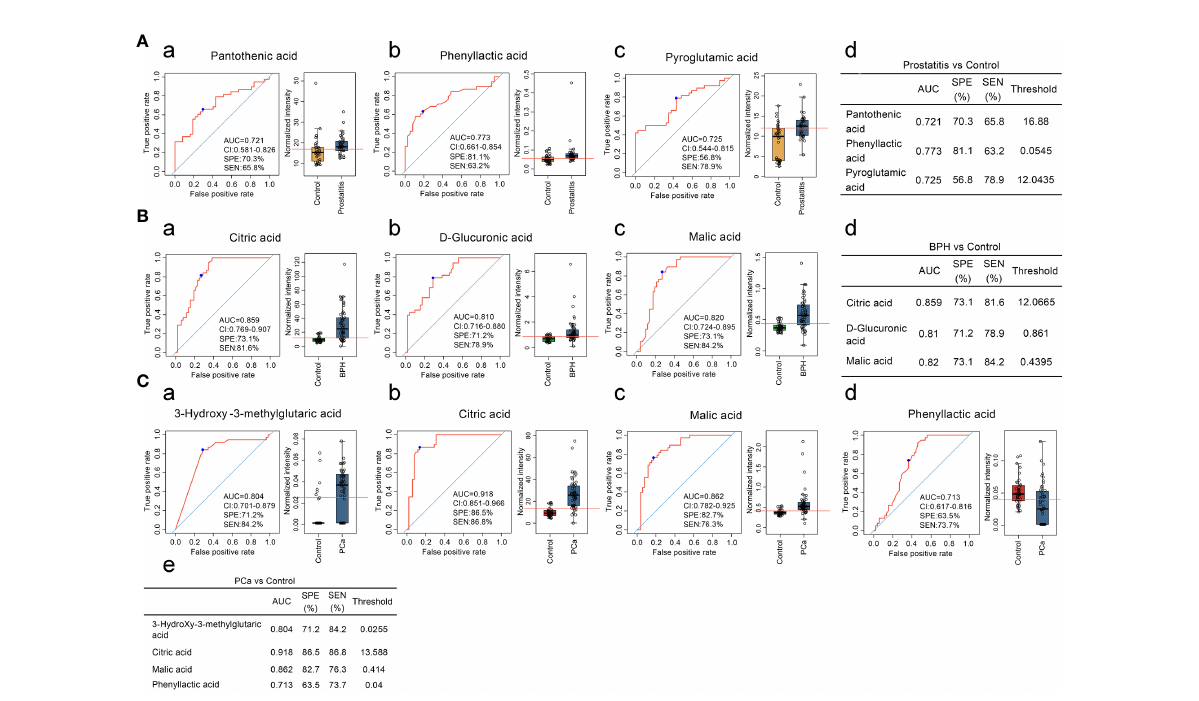
FIGURE 1 (A) Comparison of the contents of organic acid metabolites in the serum of prostatitis and normal controls and ROC curve analysis. (a, b) The contents of pantothenic acid, phenyllactic acid, and pyroglutamic acid in the serum of prostatitis patients and normal controls and ROC curve analysis of lactic acid, used to identify prostatitis. (d) Diagnostic model for identifying prostatitis with serum organic acids. (B) Comparison of the contents of organic acid metabolites in the serum of patients with BPH and normal controls and ROC curve analysis. (a – c) Content of citric acid, D-glucuronic acid, and malic acid in the serum of patients with BPH and ROC curve analysis for differentiating BPH. (d) Diagnostic model of serum organic acid metabolites for differentiating BPH. (C) Comparison of the contents of organic acid metabolites in the serum of prostate cancer patients and normal controls and ROC curve analysis. (a – d) The contents of 3-hydroxy-3-methylglutaric acid, citric acid, malic acid, and phenyllactic acid in the serum of prostate cancer patients and normal controls and ROC curve analysis of lactic acid, used to identify prostate cancer. (e) Diagnostic model of serum organic acid metabolites for differentiating prostate